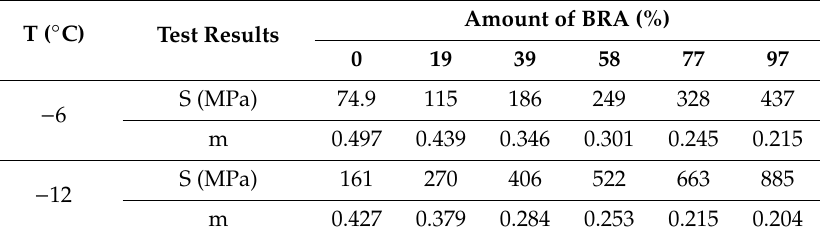
Table 15. Beam bending rheometer (BBR) test results of BRA-modified asphalt.